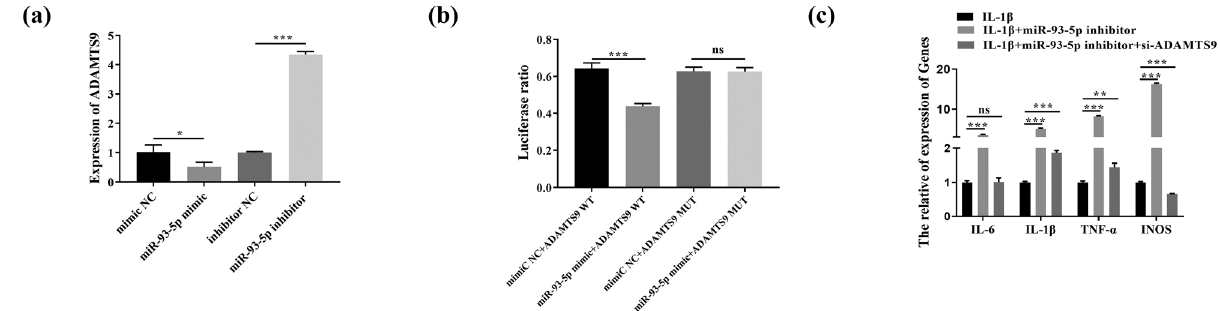
Figure 2: Validation of ADAMTS9 as a direct target gene of miR - 93 - 5p. Note: ( a ) miR - 93 - 5p mimic and miR - 93 - 5p inhibitor were transfected into OA chondrocytes to overexpress and knockdown miR - 93 - 5p, respectively. ( b ) The interaction between ADAMTS9 and miR - 93 - 5p was detected with dual luciferase reporter gene assay. ( c ) RT - qPCR was performed to detect the expression of pro - in fl ammatory factors ( IL - 6, IL - 1 β , TNF - α ) and iNOS. * P < 0.05; ** P < 0.01; *** P <